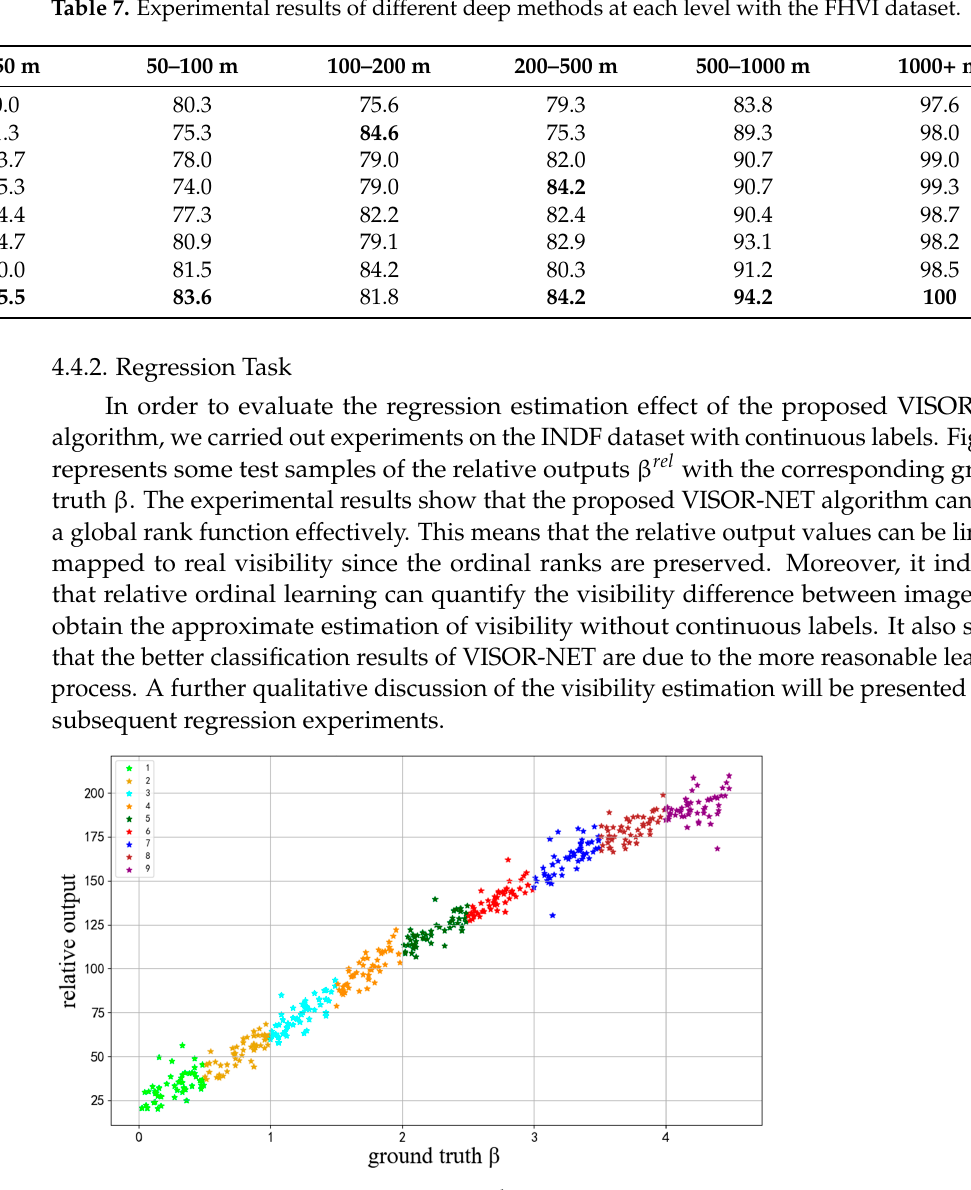
Figure 9. The relative visibility prediction β rel of VISORNET and the ground truth β with the IDNF dataset, where 50 test examples are randomly selected from each category. Table 8. The experimental results of different methods with the INDF dataset.